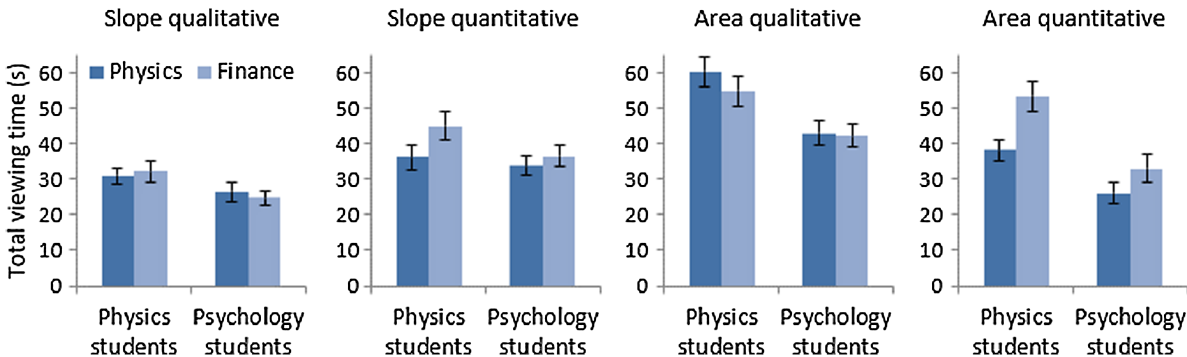
FIG. 5. Average total viewing time of physics and psychology students in the context of physics and finance on the qualitative and quantitative questions about graph slope and area under a graph. The error bars represent